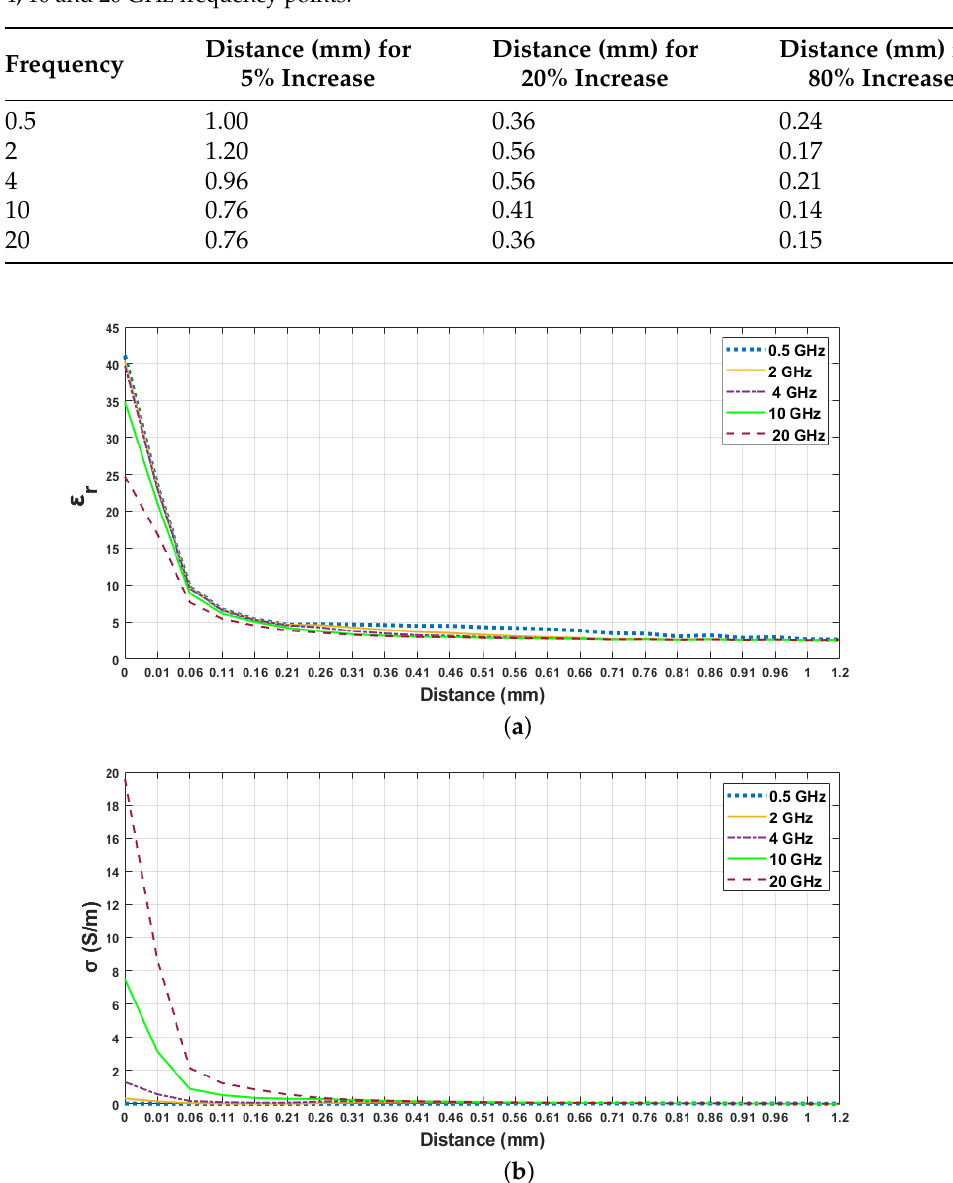
Figure 9. Retrieved dielectric properties of the double-layered skin–olive oil configuration: ( a ) relative permittivity, ( b ) conductivity as a function of probe’s distance from first layer at 0.5, 2, 4, 10 and 20